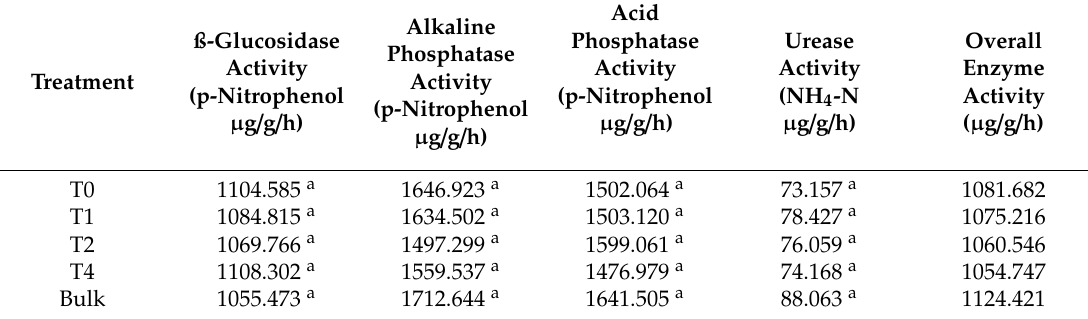
Table 5. Soil microbial enzymatic activities between cover crop treatments.